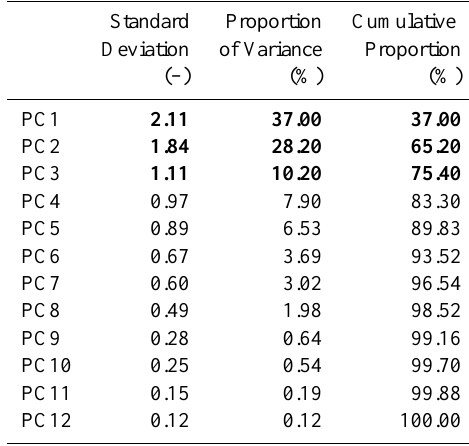
Table 3. Principal Components of X variables: variability accounted for.